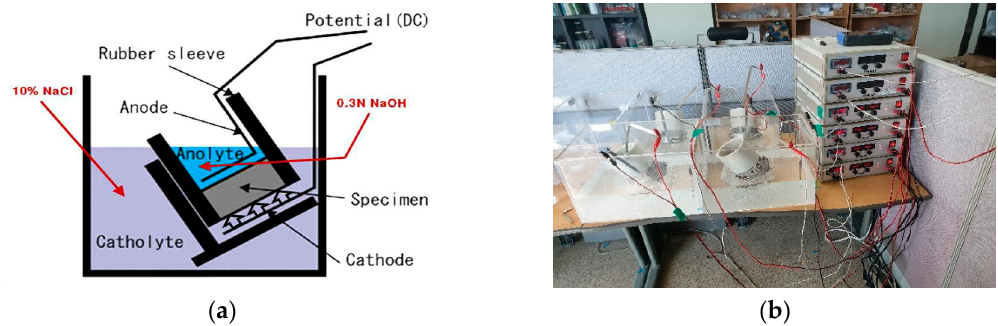
Figure 3. ( a ) Schematic diagram of NT BUILD 492 test, ( b ) Photograph image of the experimental